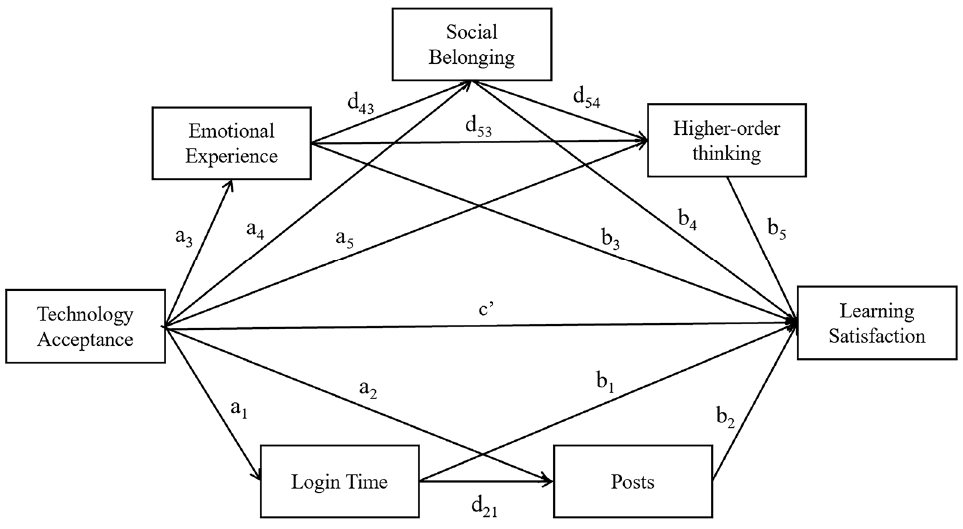
Figure 1. The research model.